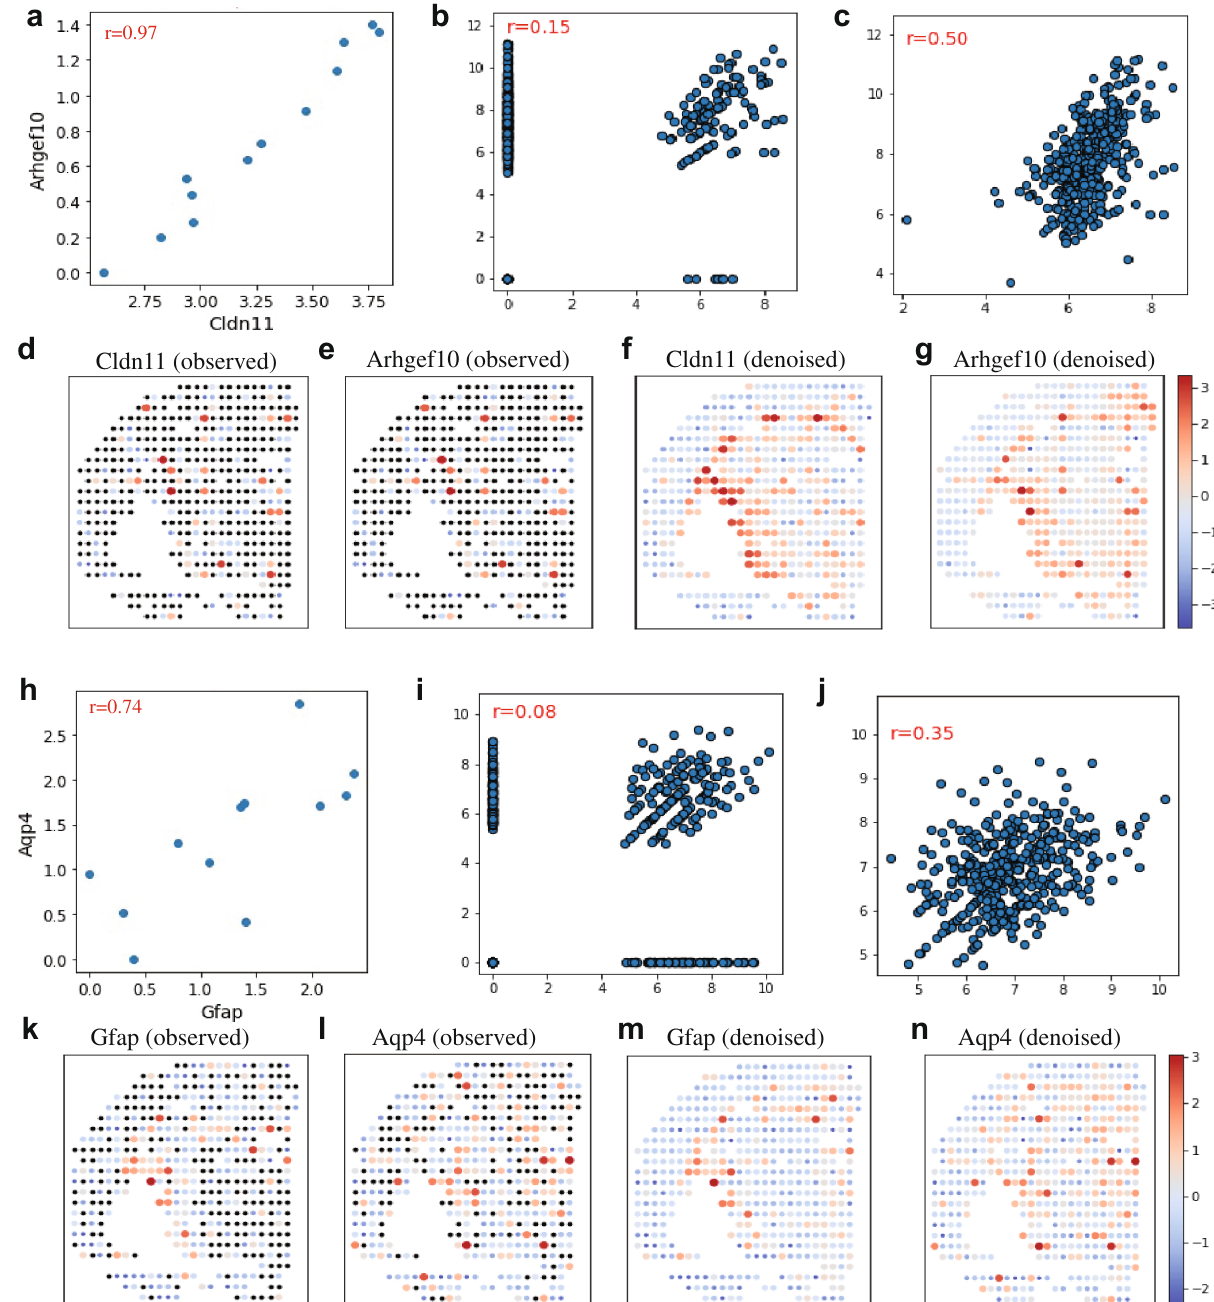
Fig. 5 | MIST recovers spatially co-expressed gene pairs. a – c Spatial correlation of Arhgef10-Cldn11 in the Allen Brain Atlas reference ( a ), the original ST data ( b ), and the MIST-denoised ST data ( c ). d Expression patterns of the Cldn11 using the original ST data; zero values are colored black and non-zero values are z score scaled for visualization. e Expression pattern of the Arhgef10 using the original ST data. f ExpressionpatternoftheCldn11usingtheMIST-denoiseddata. g Expression